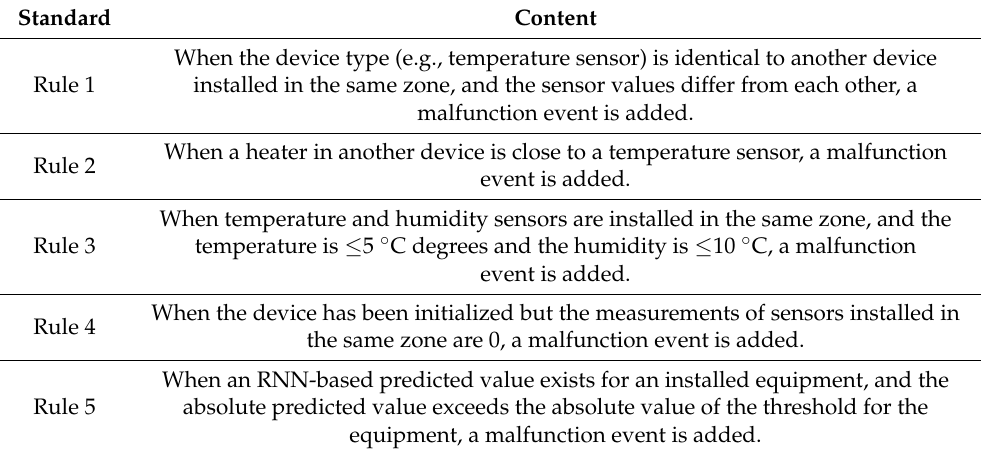
Table 1. System rules for the addition of malfunction events.